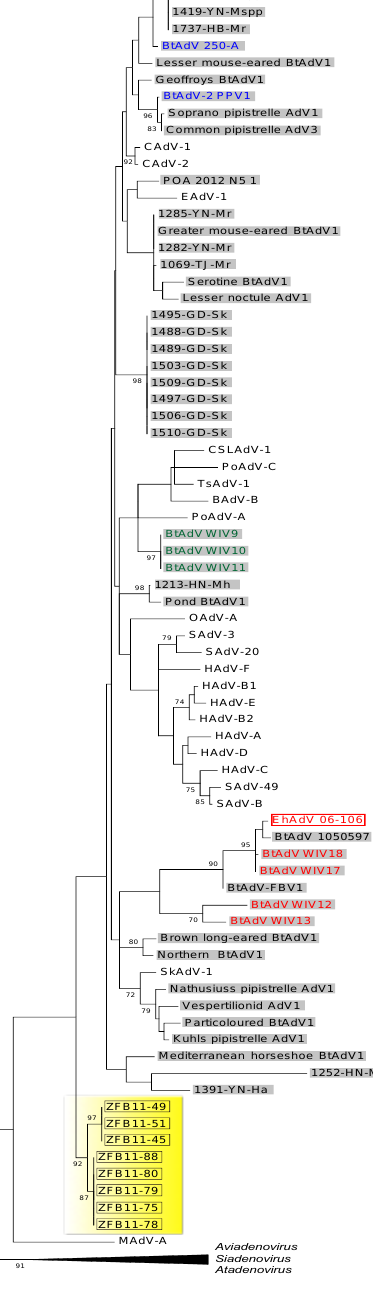
Figure 6. Maximum-likelihood phylogenetic trees based on the partial amino acid sequences of DNA polymerase (pol). The dendrogram was constructed with an LG model with gamma distribution with the highest log likelihood (−3122.742588). The percentages at nodes are bootstrap probabilities calculated using 1000 replicates and indicate bootstrap supports >70%. Open rectangles and gray-shaded rectangles indicate bat-derived adenoviruses detected in E. helvum in this study and bat-derived adenoviruses, respectively. Bat adenoviruses in groups 1 to 3 in Figure 3 are shown in colors. Eight newly detected E. helvum -derived adenoviruses are highlighted in yellow. Bar indicates the number of substitutions per site. The sequences listed in Table S1 and previously reported in bat adenoviruses [12,13].